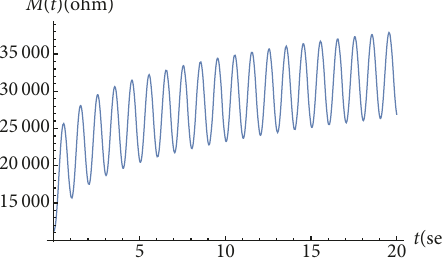
Figure 17: 𝑀(𝑡) of the fractional order memristor under the sinusoidal input with 𝐼 𝑚 < 0: 𝛼 = 1.25 .